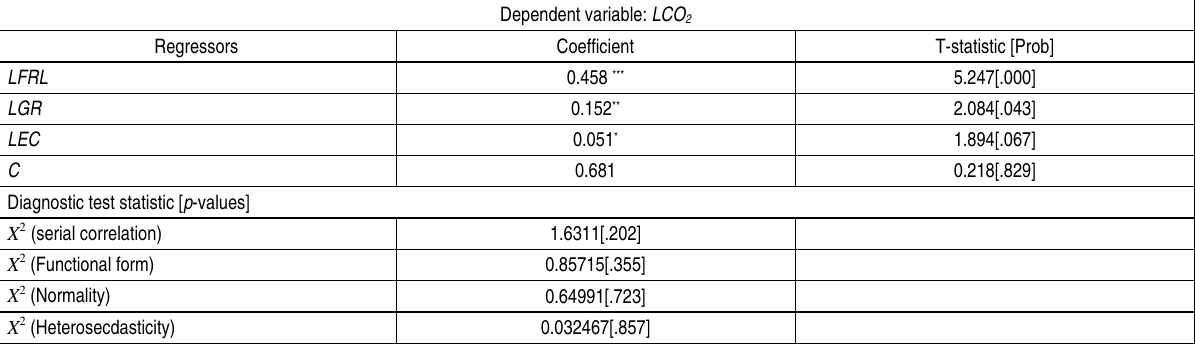
Table 4 (cont.). Long-run estimates of the model